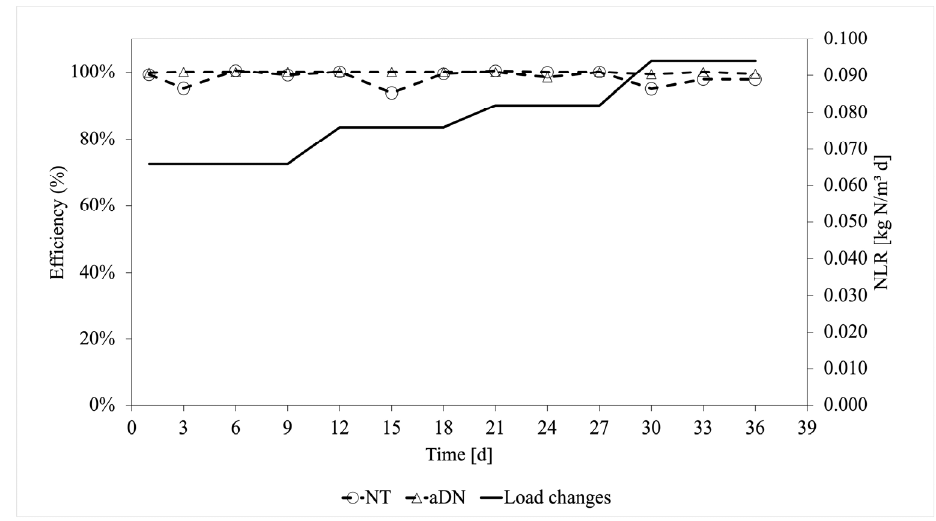
Figure 8. Results of the sequential aDN process. Nitrification (NT) and Autotrophic denitrification (aDN) efficiencies in R1.